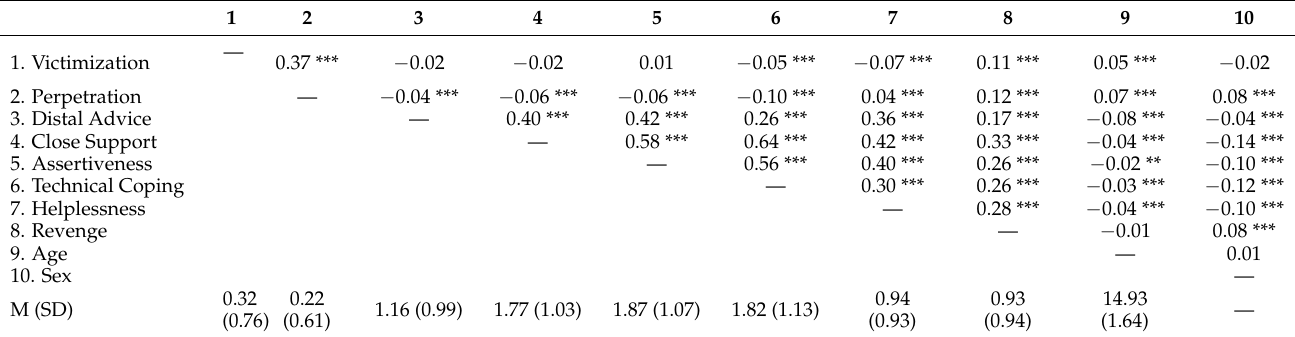
Table 2. Descriptive statistics and correlations ( n =